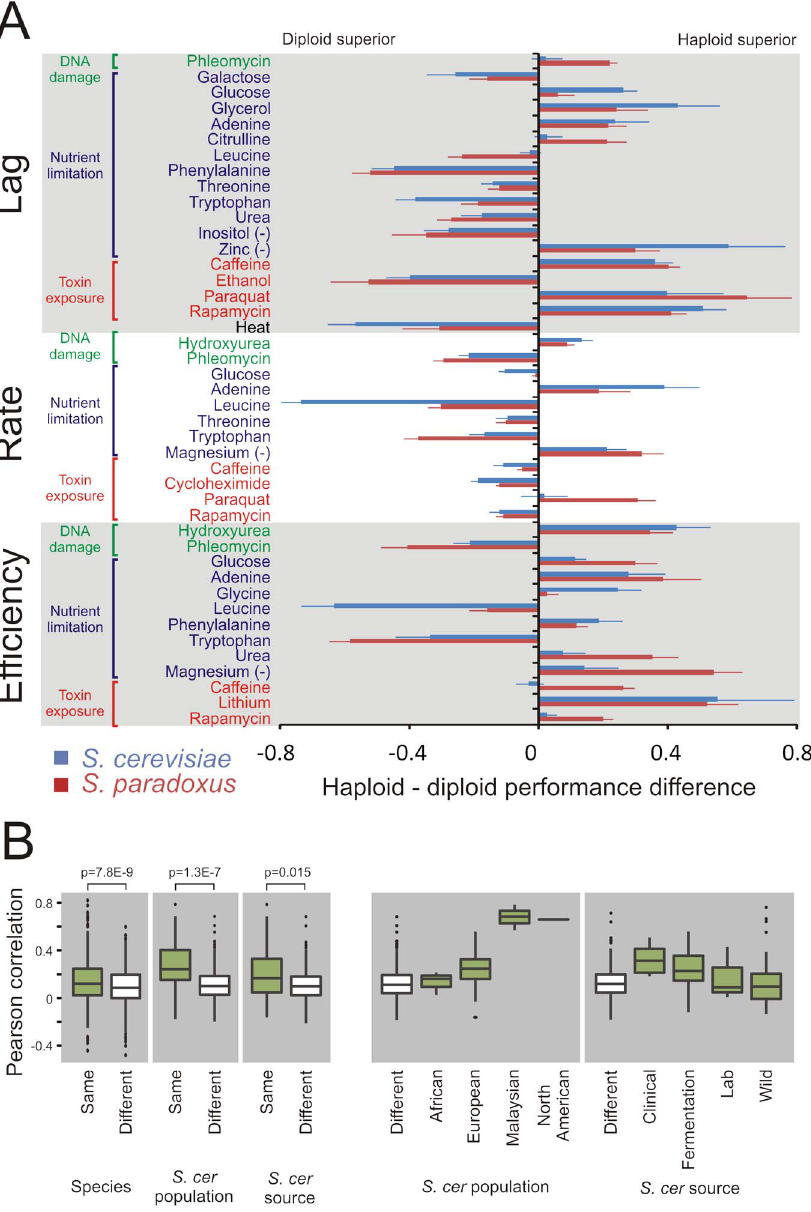
Figure 2. Ploidy–environments interactions are conserved since before the S. cerevisae and S. paradoxus radiation. A) Fitness component measures with a significant (FDR, a =0.05) difference in performance between haploids and diploids in S. cerevisiae , in S. paradoxus or in both species. To compare haploid and diploid asexual proliferative capacity, a mean of the log(2) relative performance of the two haploid mating types (each n=2) was used to derive a single measure of haploid performance. This was compared to that of the diploid (n=4), by calculating the mean difference between haploid and diploid phenotypes. Each species was treated separately. Error bars represent the SEM (n=24 for S. cerevisiae , n=27 for S. paradoxus ). B) Left panels show pairwise Pearson correlation coefficients, based on ploidy effects over all mitotic traits, between strains belonging to the same (627 pairs) or different (648 pairs) species, the same (43 pairs) or different (233 pairs) S. cerevisiae population and the same (65 pairs) or different (211 pairs) S. cerevisiae source environment. Species, population and source environment, all have significant impact on ploidy effects (ANOVA F-test; p-values displayed, note the large sample size for the between/within species comparison, and the correspondingly low SEM), but explained only 2.5%, 9.3% and 1.8% of the overall variation in correlation coefficients (R2-adj). Right panels resolve S. cerevisiae populations into the Malaysian, European, African and North American populations and S. cerevisiae sources into Clinical, Fermentation, Lab and Wild strains. Top and bottom of boxes represent 25th and 75th quartiles, bands represent medians, whiskers show the lowest and highest data point still within 1.5 interquartile range of the lower and upper quartile respectively and filled circles represent data points outside this range. doi:10.1371/journal.pgen.1003388.g002 In S288c growth efficiency during Cu 2 + or Li + exposure, at the consistently superior proliferation efficiency during exposure to heat, Cu 2 + or Li + , presumably reflecting more efficient utilization relevant pH (5.8), is almost completely determined by recent gene of energy. amplifications of the copper chelating metallothionein CUP1 and